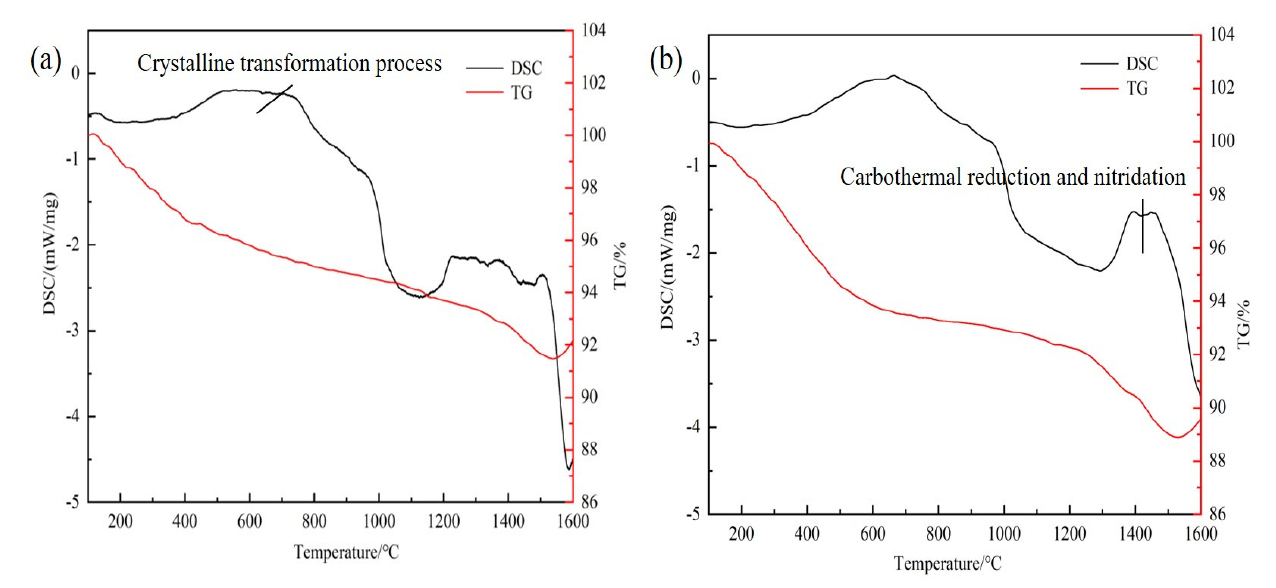
Figure 5. TG–DSC curves of the Al 2 O 3 /C mixed powder with different contents of dispersants in nitrogen: ( a ) 0 wt%; ( b ) 5 wt%.